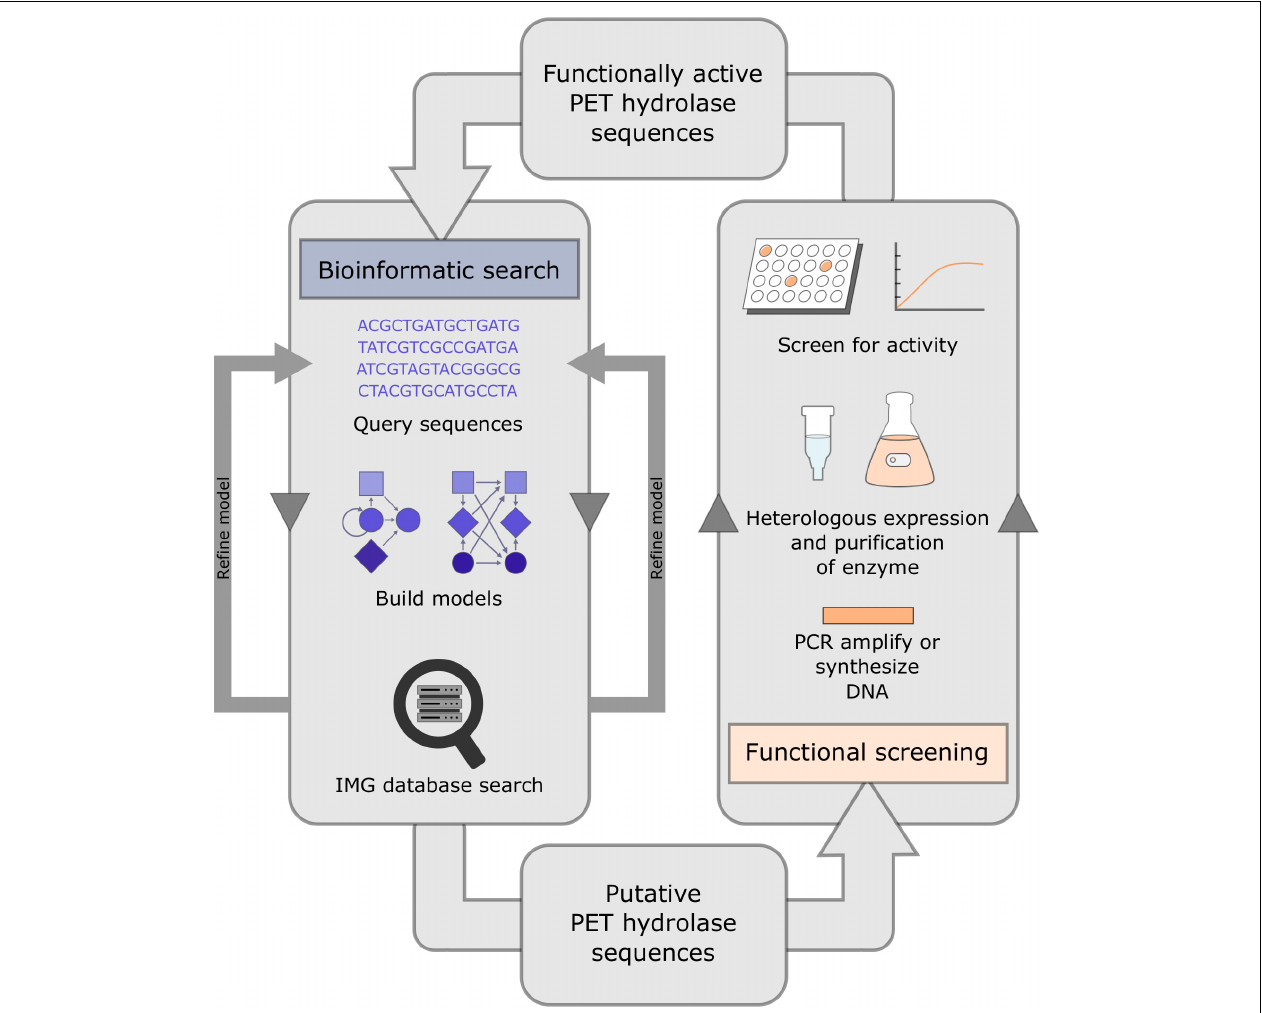
FIGURE 3 | System for the identification and functional testing of candidate PET hydrolase enzymes. Potential PET hydrolase sequences may be uncovered with an initial bioinformatic search of existing databases, by employing hidden Markov models. Candidate genes are then cloned into a heterologous host to verify activity against substrates, e.g., PCL and